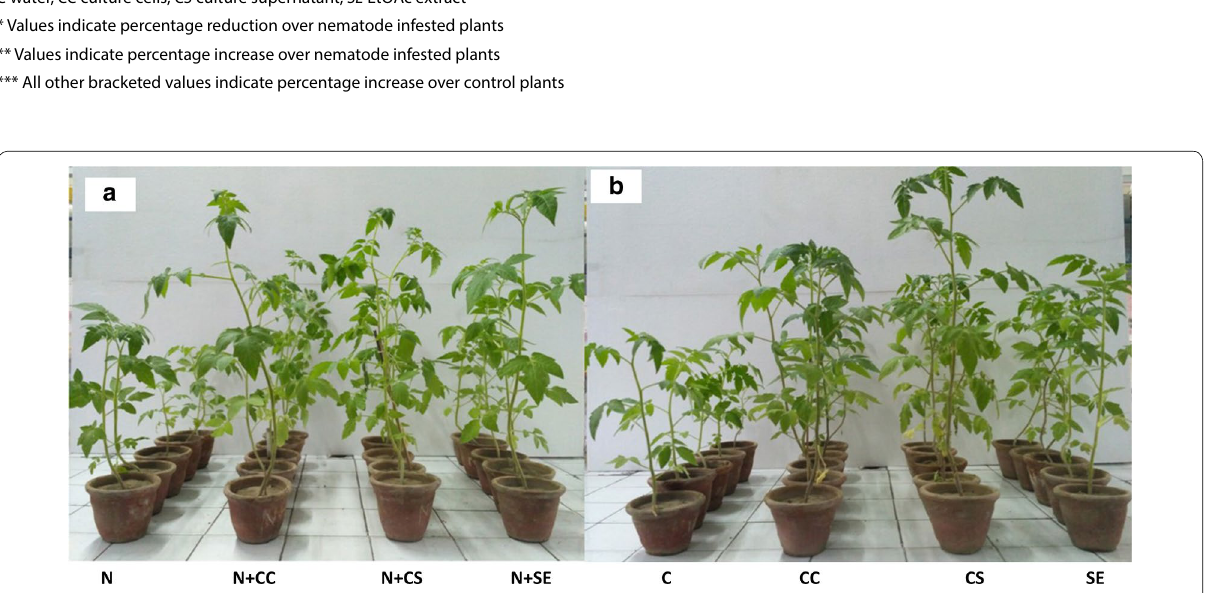
Fig. 3 In vivo protective effect of S. antibioticus strain M7 and its metabolites on shoot growth of Solanum lycopersicum plants: a infested with M. incognita and b without nematode infestation: C (water), N (nematode), CC (culture cells), CS (culture supernatant), and SE (EtOAc